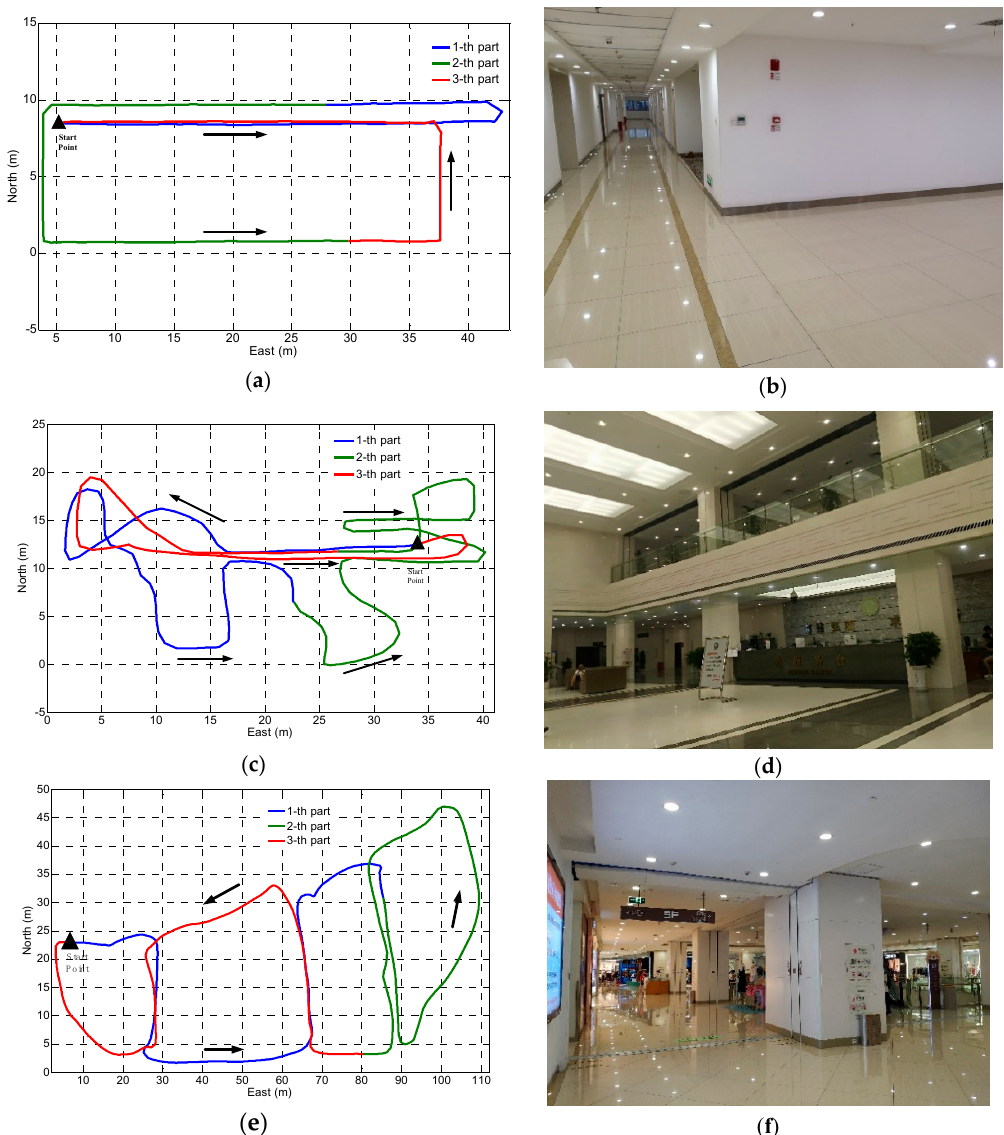
Figure 6. Trajectories of the experiments. ( a ) The trajectory in building A; ( b ) experimental environment of building A; ( c ) the trajectory in building B; ( d ) experimental environment of building B ( e ) the trajectory in building C; ( f ) experimental environment of building C.